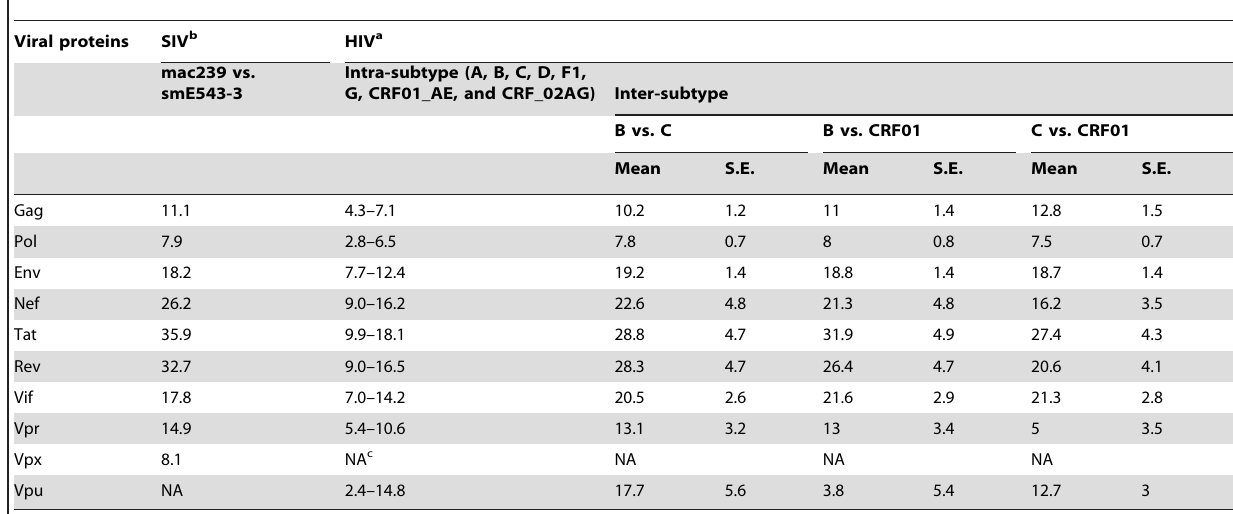
Table 1. Differences between the vaccine and challenge SIV and inter-subtype differences of HIV-1.